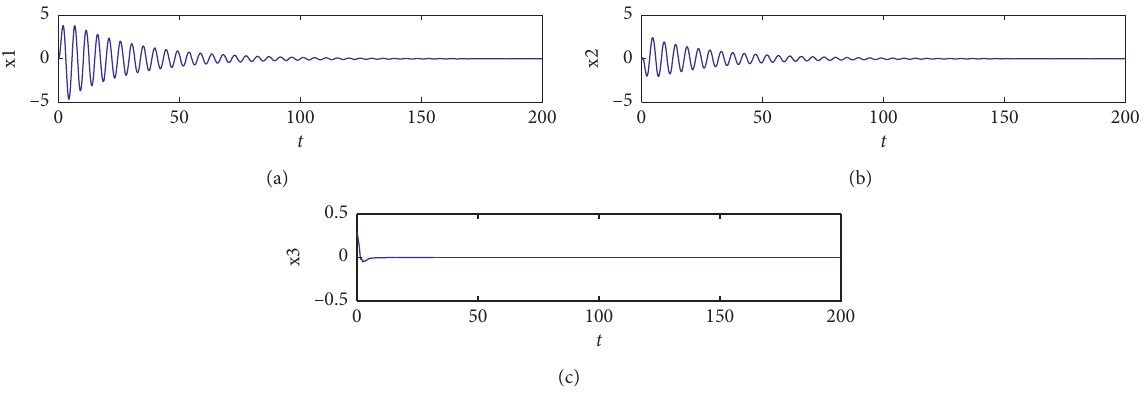
Figure 1: System (31) is asymptotically stable with α � 1.21.